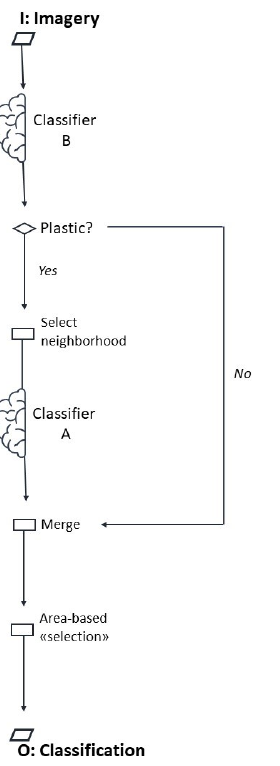
Figure 9. Block diagram of process of classification.